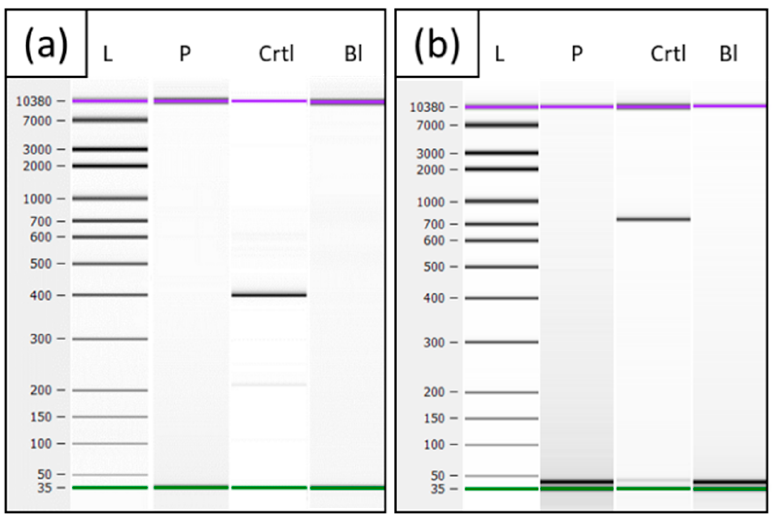
Figure 5. Electrophoresis of cDNA ( a ) cDNA PCR fragment of SGCG Ex1 ‐ 4 from the patient (P) a healthy control (Ctrl) and a blank value (Bl). ( b ) cDNA PCR fragment of LINC00621 Ex2 ‐ 4 from patient (P), a healthy control (Ctrl), and blank value (Bl).